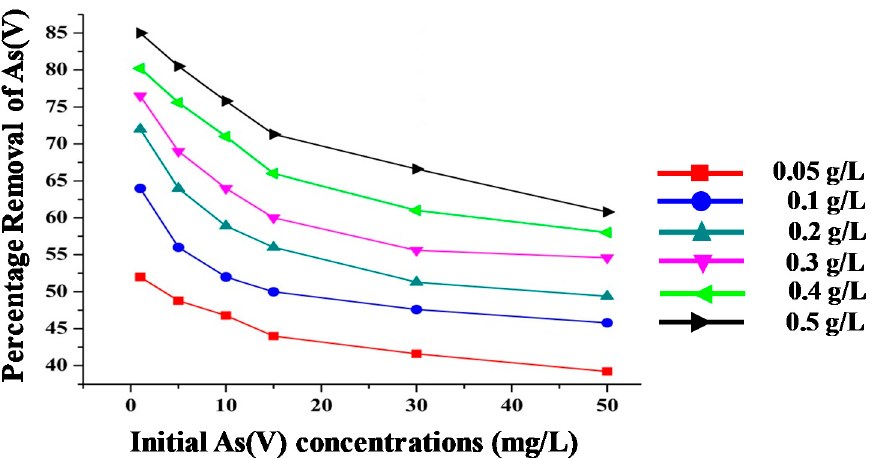
Figure 6. Effect of different doses of T. chebula -synthesized IONPs on removal of As(V) at different concentrations of As(V).